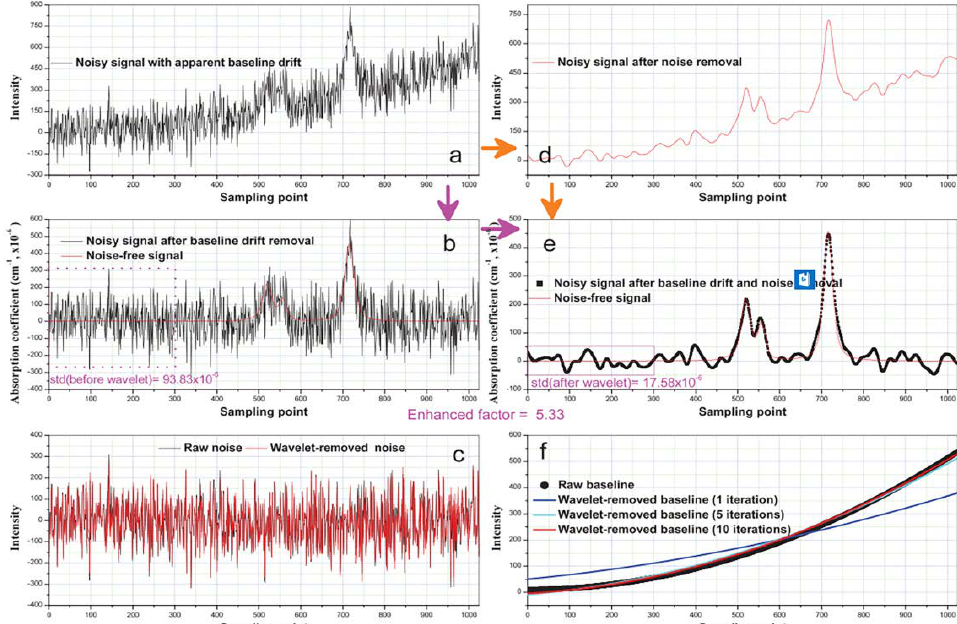
Figure 13. Nonlinear baseline correction and denoising using DWT. ( a ) Noisy signal with apparent baseline drift; ( b ) baseline drift removed signal from ( a ) and noise-free signal; ( c ) raw noise and wavelet-removed noise; ( d ) denoised signal from ( a ); ( e ) baseline drift removed signal from ( d ) and noise-free signal; ( f ) raw baseline and wavelet-removed baseline. This figure was obtained from [52].